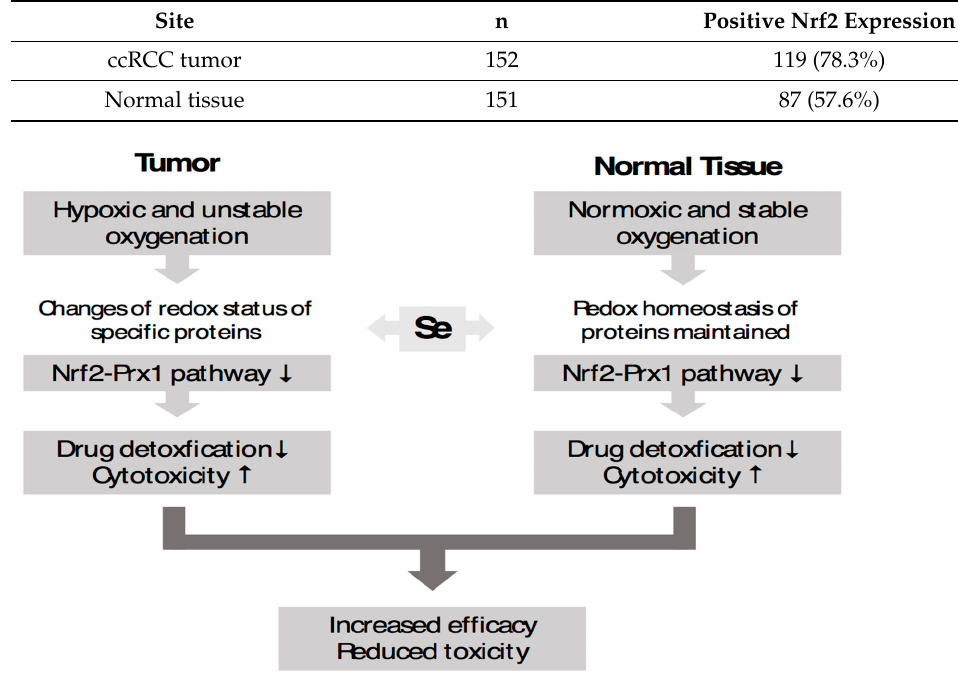
Figure 4. Differential regulation of Nrf2 expression by methylselenocystein (Se) in tumor and normal tissues [72]. Se upregulates Nrf2 in normal mouse tissues and downregulates its expression in tumor tissues.